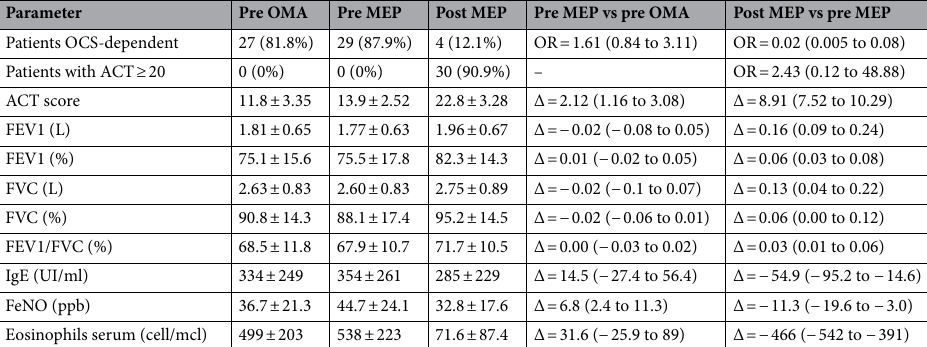
Table 2. Clinical evolution of disease in the three periods considered in the analysis. Continuous data are reported as mean ± standard deviation. Dichotomous data as absolute number (percentages), and